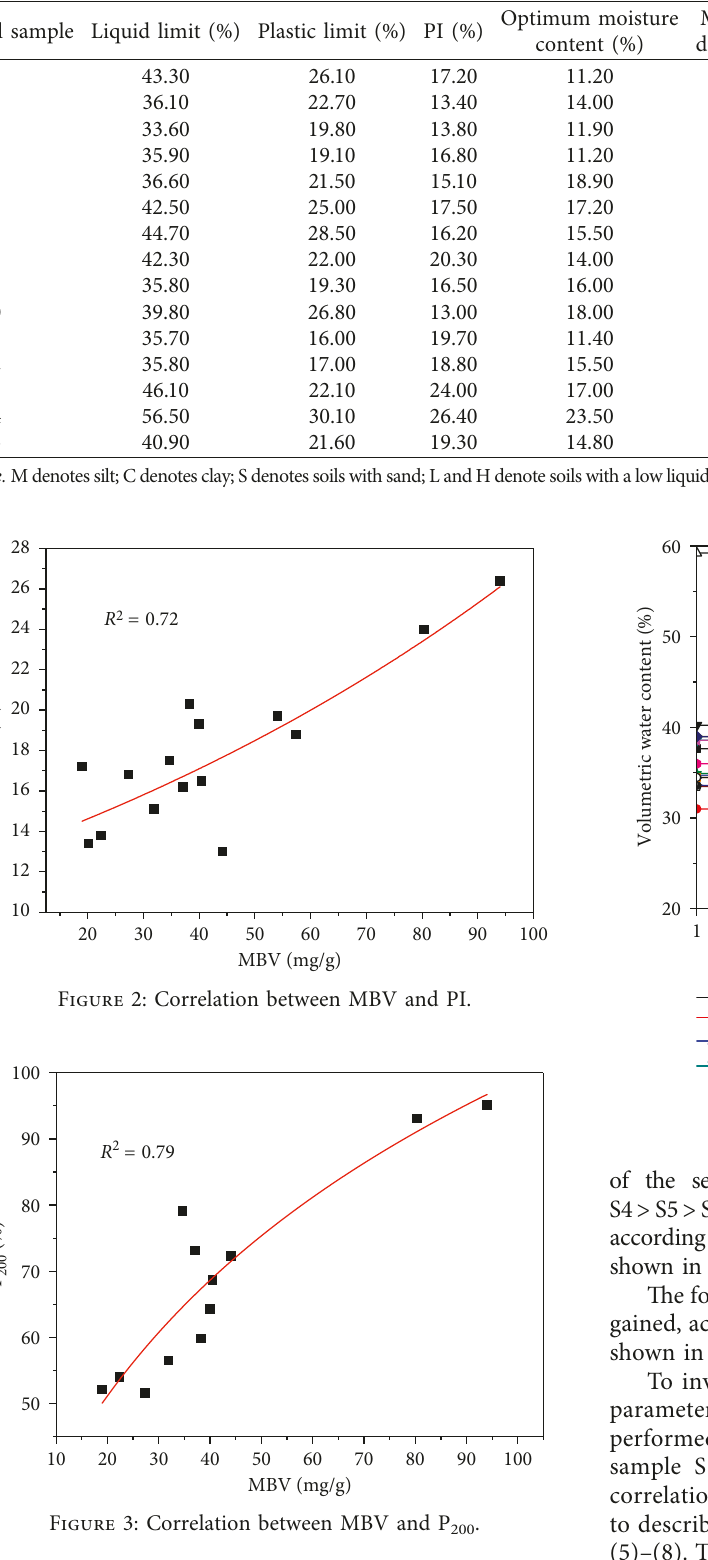
Table 2: Testing